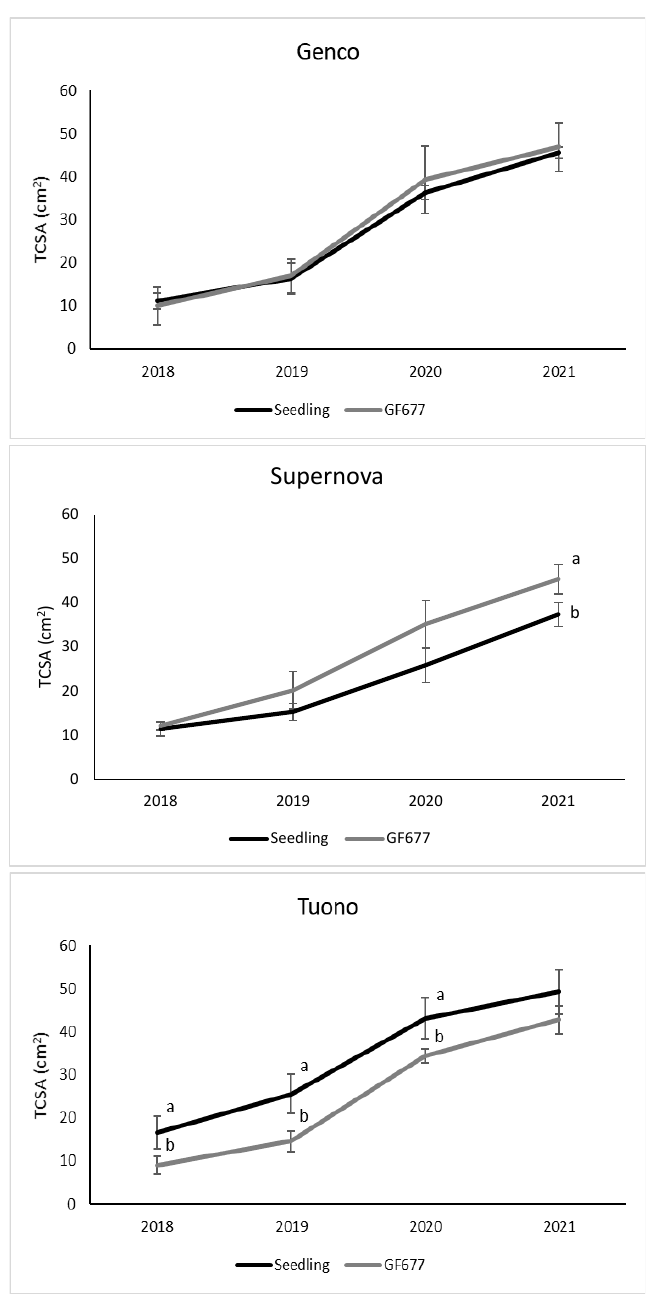
Figure 3. Comparison of annual mean values of trunk cross-sectional area (TCSA) computed at 30 cm above the ground, and recorded at the end of growing season over the period 2018–2021 for cultivars ‘Genco’, ‘Supernova’ and ‘Tuono’, grafted on ‘GF677’, and on peach seedling rootstocks (trial A). Lowercase letters on the graph mean values indicate significant differences between rootstock per year (Fisher’s test p <